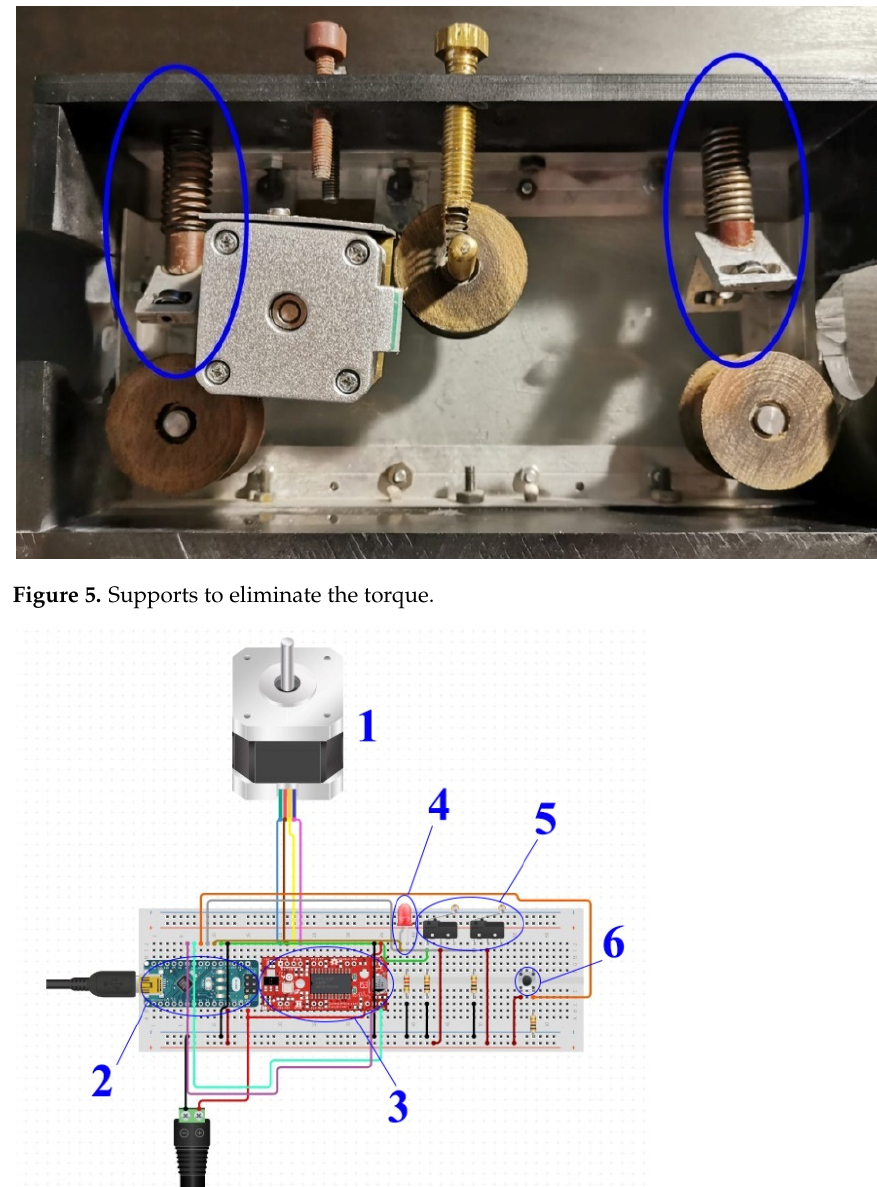
Figure 5. Supports to eliminate the torque.